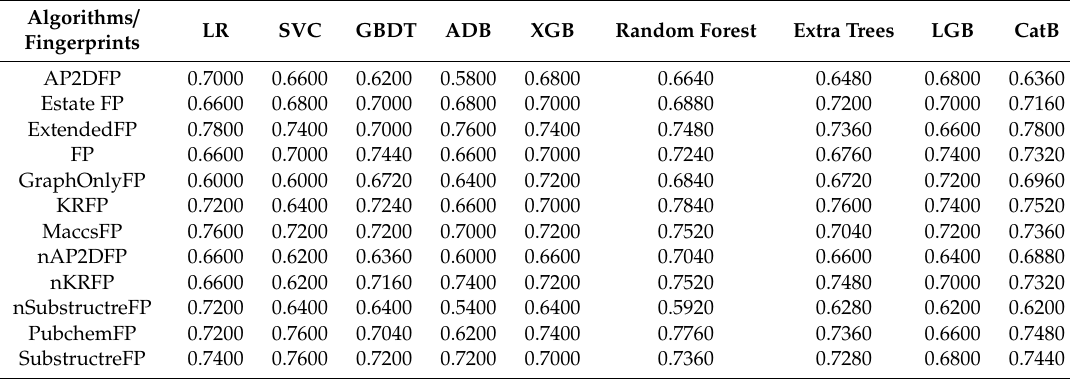
Table 3. Performance Comparison of Base Classifiers on the Test Dataset.